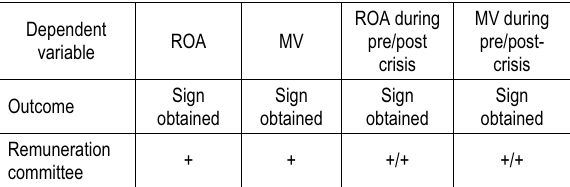
Table 8. Summary of the regression